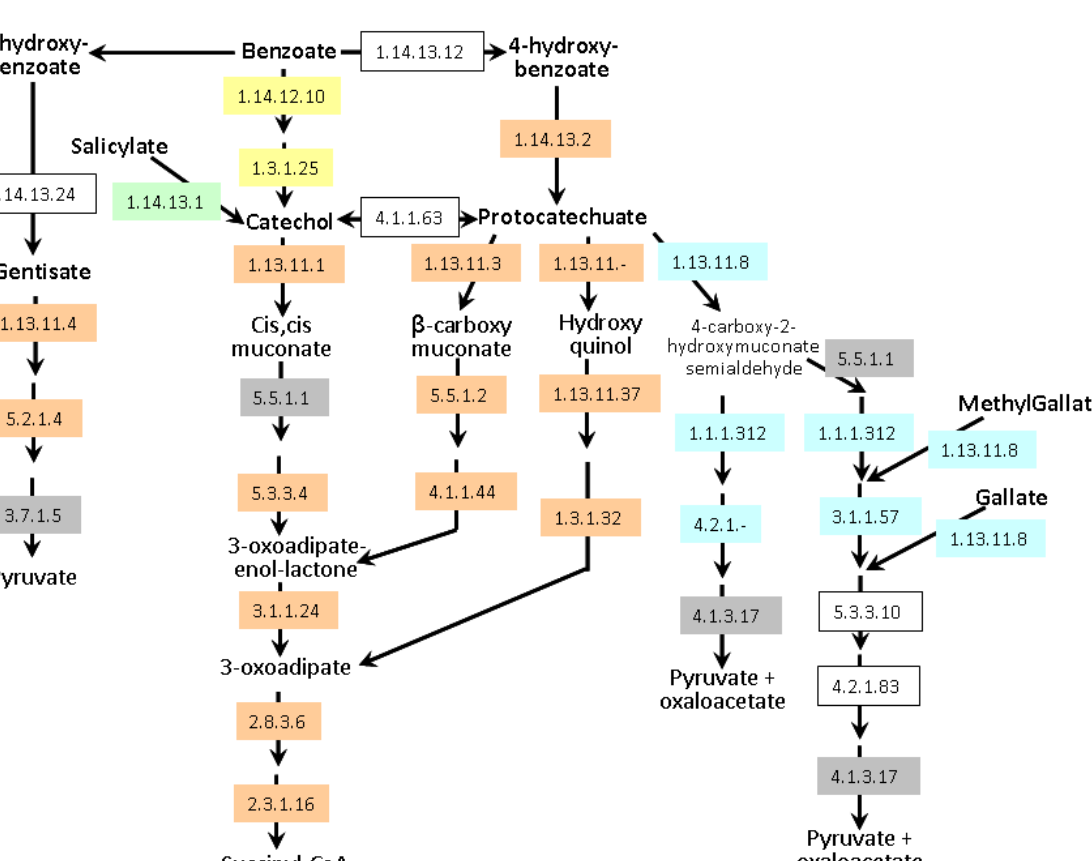
Figure 6. Aromatic compounds catabolism in Azospirillum . Enzymes framed in grey are encoded by all genomes. Enzymes framed in orange are encoded exclusively by genomes of A. lipoferum 4B and Azospirillum sp. B510. Enzymes framed in yellow are exclusive to Azospirillum sp. B510. Enzymes highlighted in blue are specific to the A. brasilense strains (Sp245 and CBG497). Conversion of salicylate into catechol (green) is encoded by all genomes except that of Azospirillum sp. B510. Non-colored enzymes are missing in all strains. Enzyme 1.1.1.312 was previously known as 1.2.1.45. Alternative names for gentisate and protocatechuate are respectively 2,5-hydroxybenzoate and